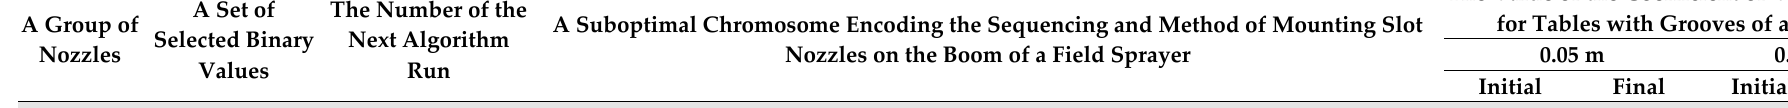
Table 1. Suboptimal chromosomes encoding the sequencing and method of mounting slot nozzles on the boom of a field sprayer.